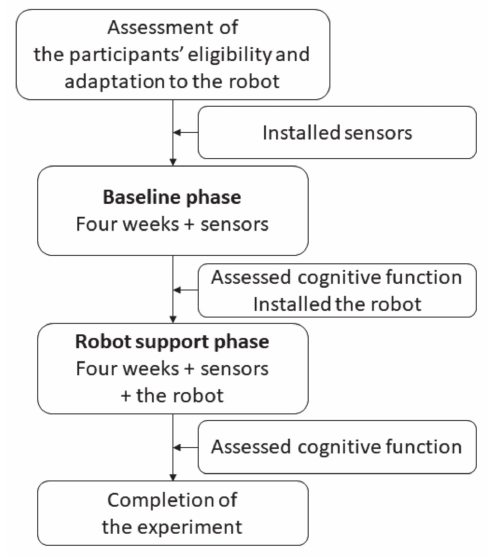
Figure 1. Procedure overview.